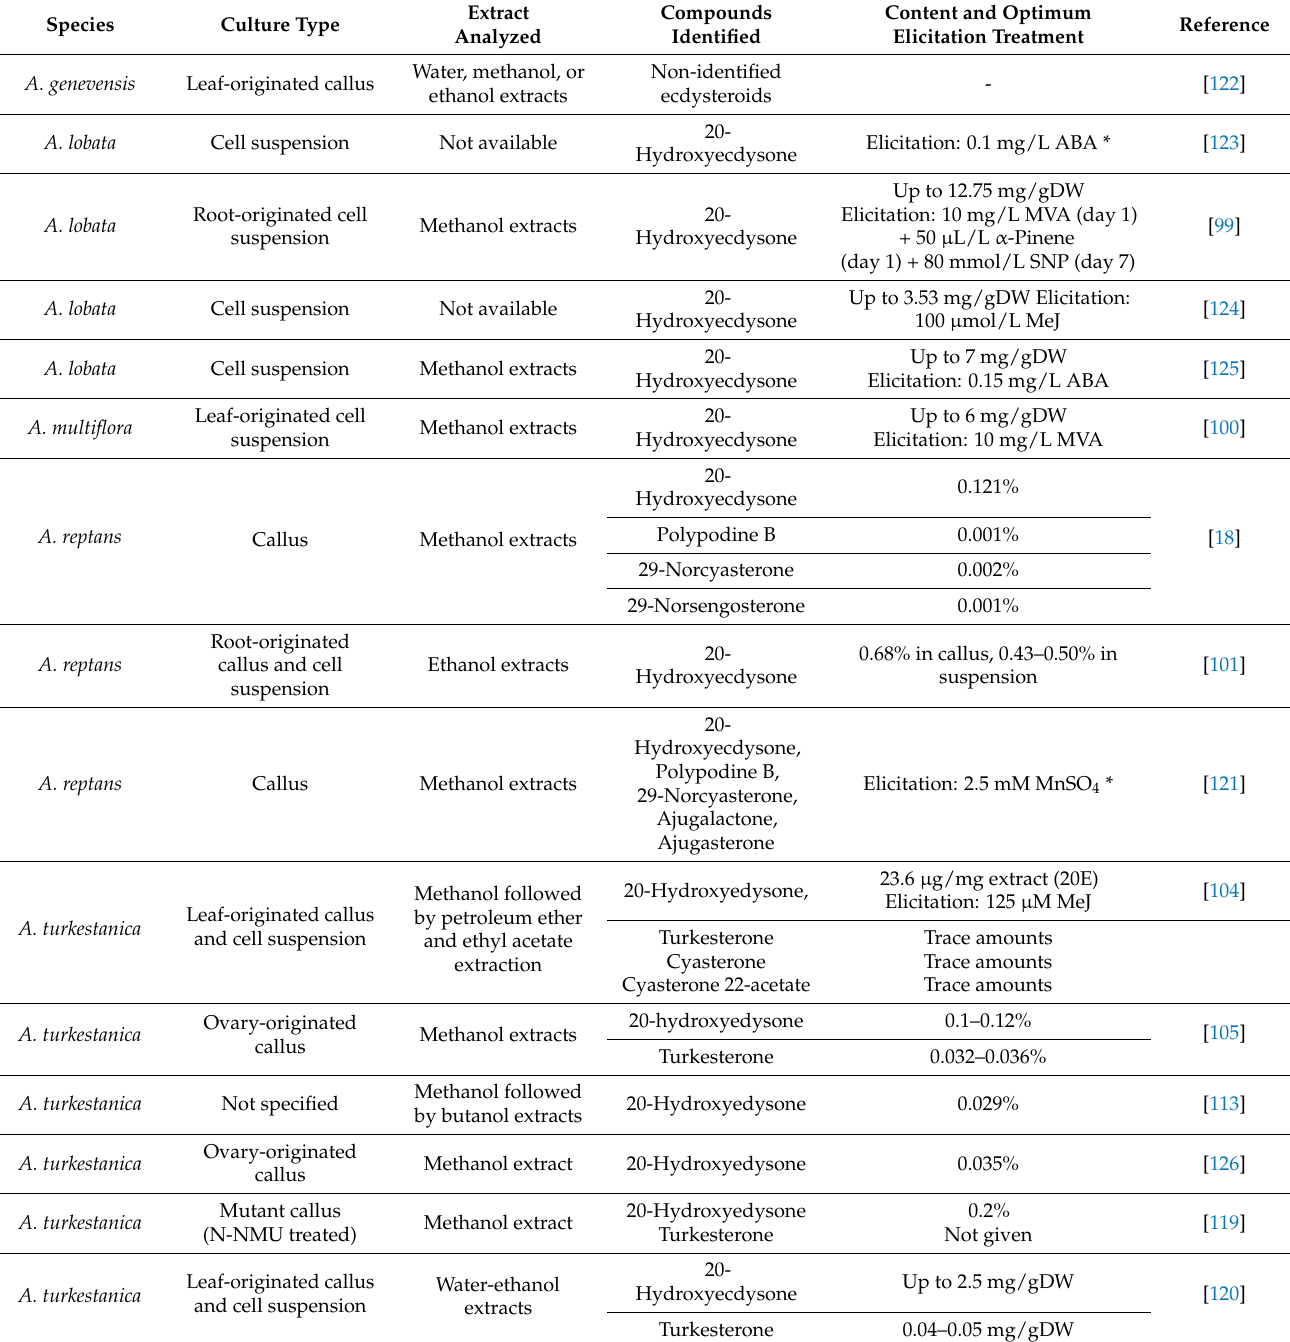
Table 3. Biosynthesis of phydoecdysteroids in cell cultures of Ajuga spp. and elicitation conditions for maximum PEs